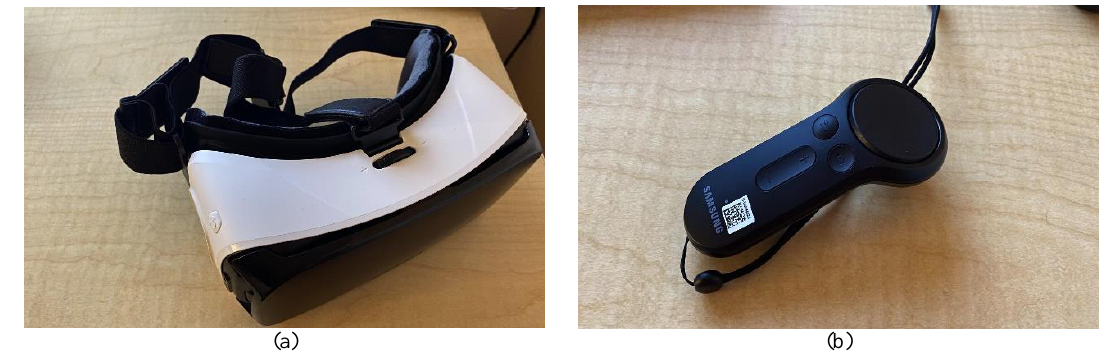
Figure 3. Surveying VR implementation: Samsung VR system ( a ) and control device ( b ).